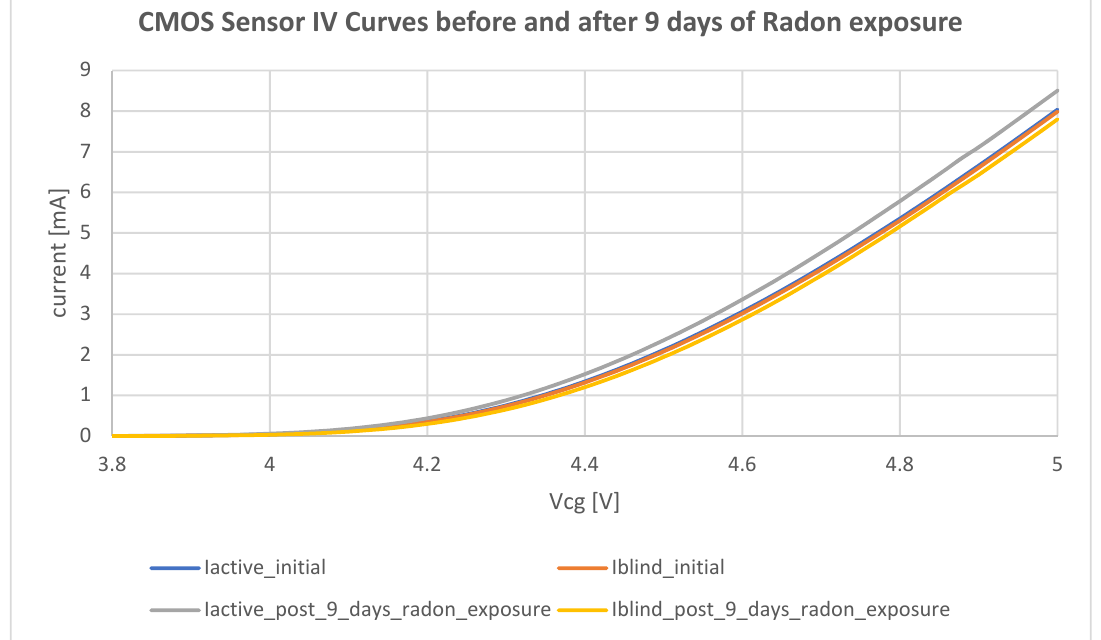
Figure 10. IV curve of blind and active arrays, before and after 9 days of Radon exposure.